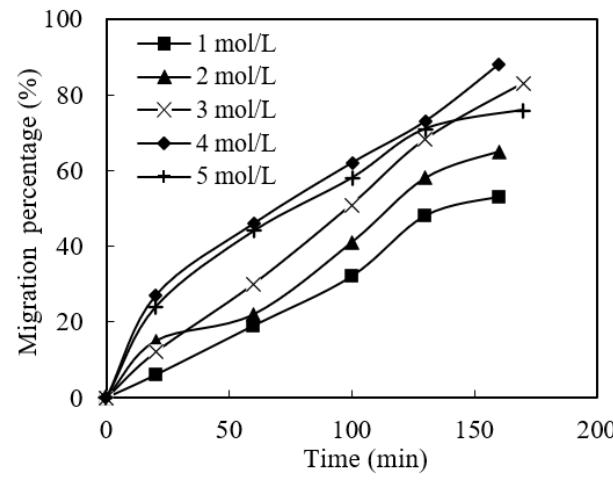
Figure 8. Effect of aqua fortis molarity on migration of Pr(III).